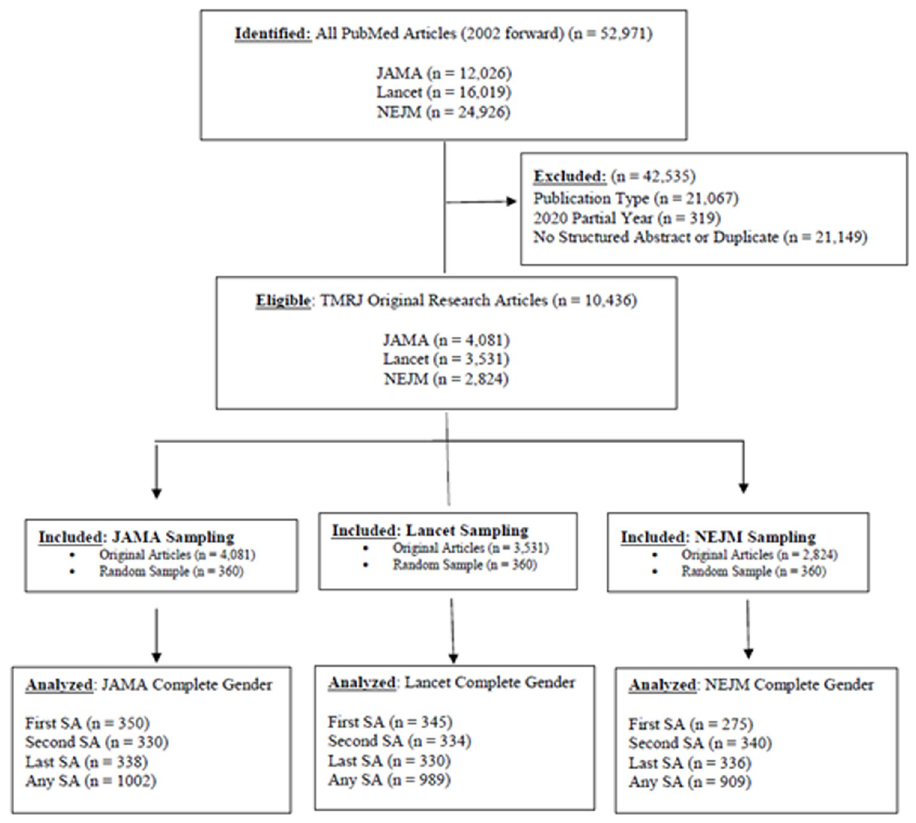
Fig 1. Article inclusion/exclusion flow diagram.